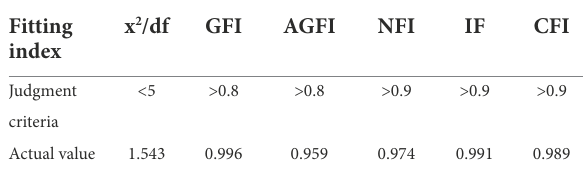
TABLE 4 Modified model